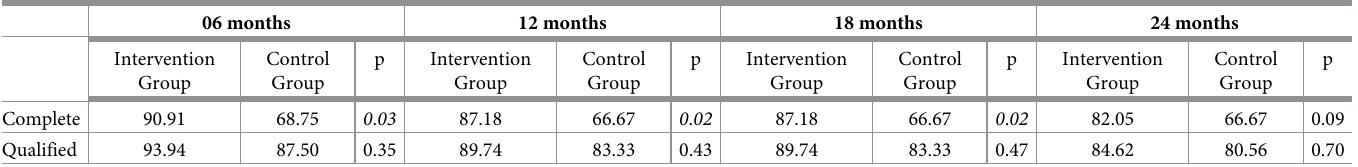
Table 5. Comparison of surgical success rates between groups at all timepoints.